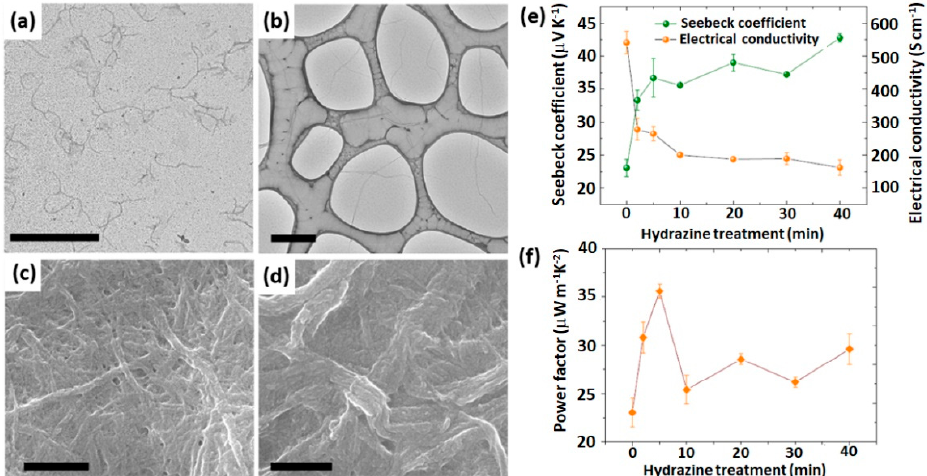
Figure 2. Transmission electron microscopy (TEM) images of ( a ) T-PEDOT nanowires and ( b ) C-PEDOT nanowires. Scanning electron microscopy (SEM) images of ( c ) T-PEDOT nanowires and ( d ) C-PEDOT nanowire-based films. The scale bar is 500 nm for all images. ( e ) S, σ , and ( f ) power factor of C-PEDOT nanowire-based film with respect to the hydrazine treatment duration. Readapted with